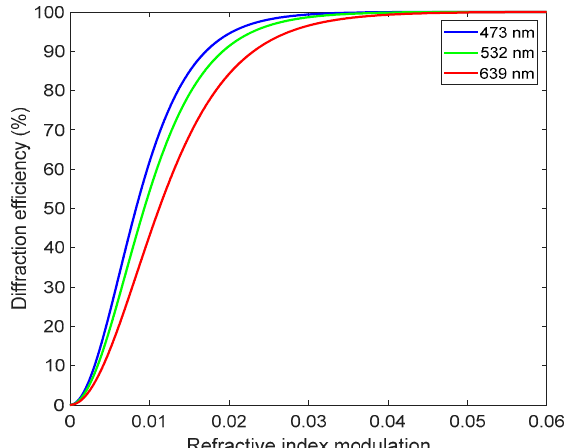
Figure 1. Reflective volume holographic grating: the relationship between refractive index modula- tion and diffraction efficiency.